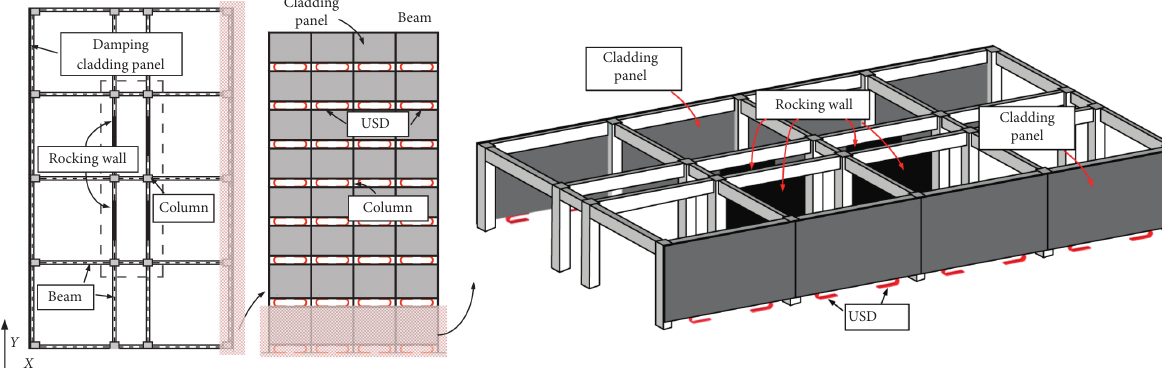
Figure 2: Schematic of a PRCFCP-USD-RW